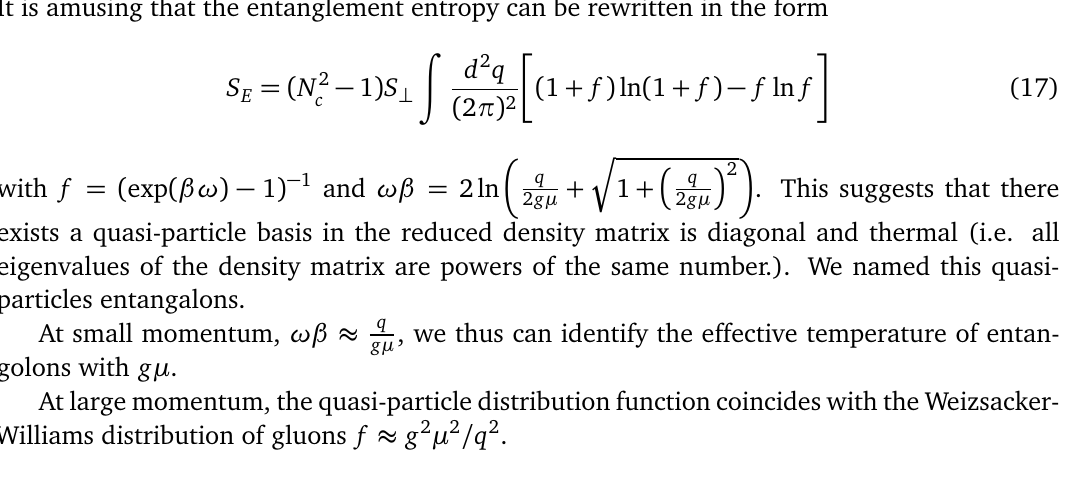
Figure 1: Ratios of entropy densities at a given magnitude of the transverse momen- ( q 2 ) is the von Neumann entropy density of ignorance and S tum q / g µ . S I the corresponding entanglement entropy